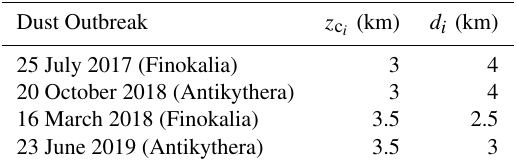
Table 1. Dust layer central height and depth, as derived from the PLDR